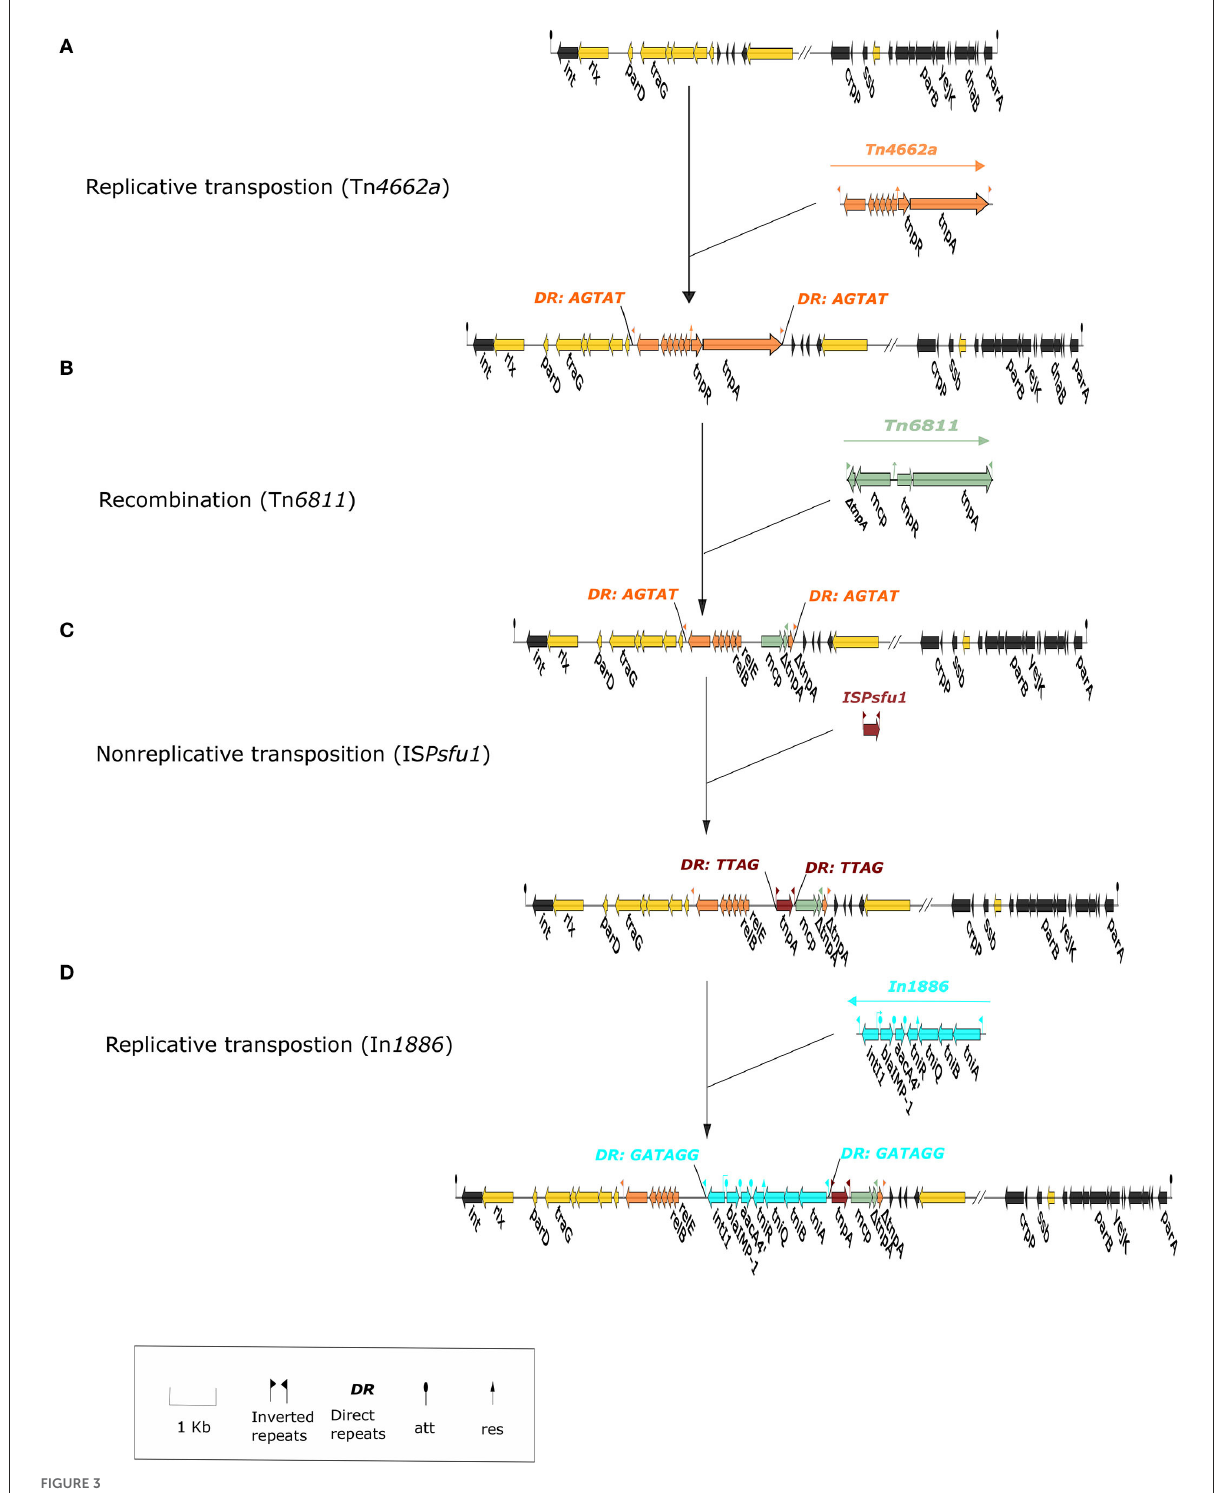
FIGURE3 The formation process of integrative and conjugative element (ICE) 1276. The figure shows the ICE 1276 structure as a local structure. The integration region of ICE 1276 is yellow, the backbone region is black, In 1886 is light blue; (A) Tn 4662a wasrecombined in ICE 1276 through replicative transposition and produces bilateral directed repeat sequence (DRs) (AGTAT); (B) Tn 6811 and Tn 4662a underwent recombination to form the 1 Tn 4662a - 1 Tn 6811 structure; the truncated part of Tn 4662a includes tnpA , complete deletion of tnpR, and the recombination sites res_site_II and res_site_III; (C) IS Psfu1 was inserted into 1 Tn 4662a - 1 Tn 6811 through non-replicative transposition and produced bilateral DRs (TTAG); (D) In 1886 was inserted upstream of the res_site_I in 1 Tn 4662a through replicative transposition and produced bilateral DRs